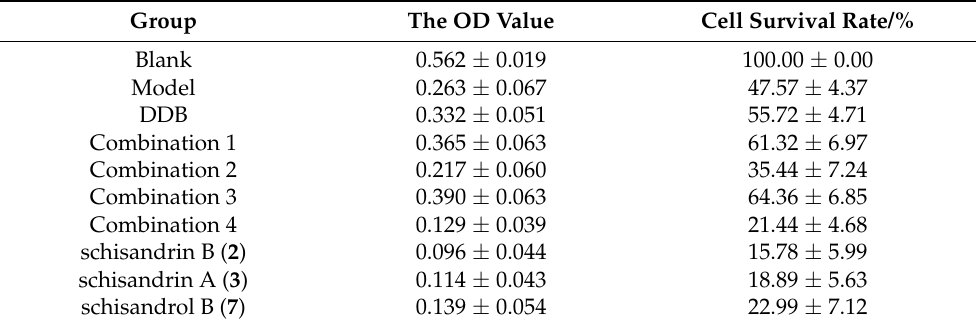
Table 7. The protective activity of schisandrin B ( 2 ), schisandrin A ( 3 ) and schisandrol B ( 7 ) against CCl 4 -induced liver injury ( x ± s , n =